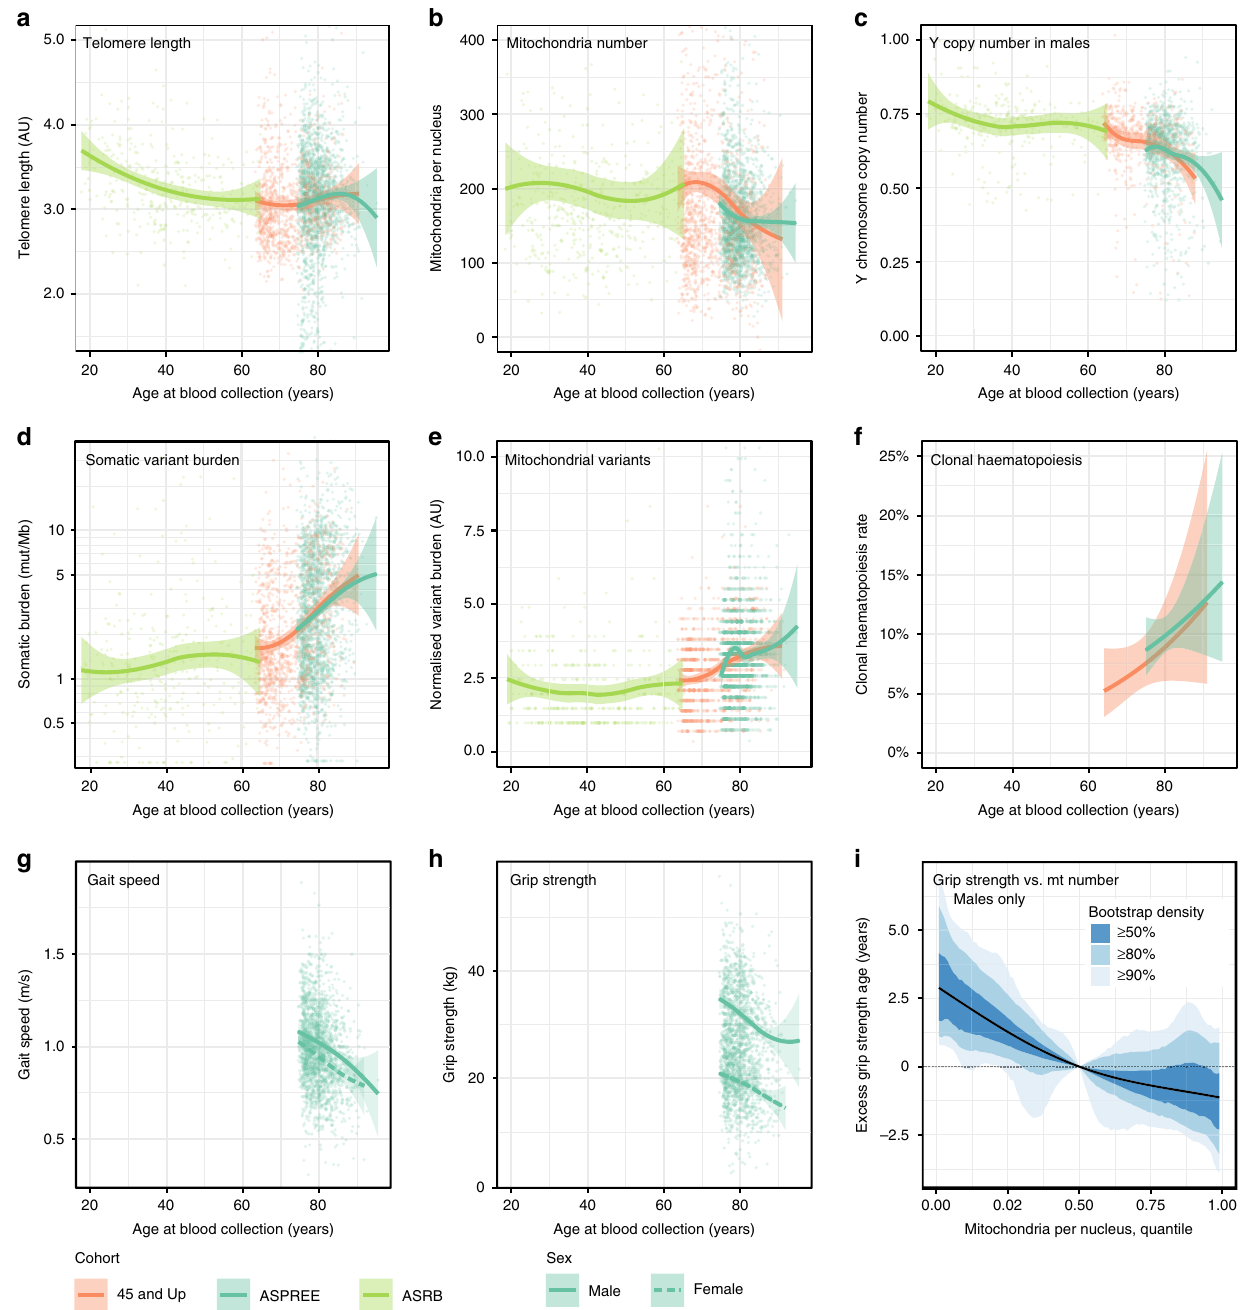
Fig. 3 Age-related somatic changes are associated with measures of physical function. Across multiple cohorts, a consistent decrease with age is observed for telomere length ( a ), mitochondria per nucleus ( b ), and Y copy number in males ( c ). In contrast, advanced age is associated with an increase in somatic mutation burden ( d , e ) and the fraction of samples with detectable clonal haematopoiesis ( f ), as well as a decrease in the key physical function measures gait speed ( g ) and grip strength ( h ). The count of mitochondria per nucleus is signi fi cantly related to grip strength beyond age alone in men, as indicated by the change in effective age as judged by grip strength with varying mitochondria count ( i ). For a – c , g , h individual measurements corrected for cohort batch effect are shown with LOESS smooths, and for d a logistic fi t was used. Bands around estimates delimit 99% con fi dence intervals for the mean. Sample numbers were 1853 for the ASPREE cohort, 717 for the 45 and Up Study, and 344 for the ASRB